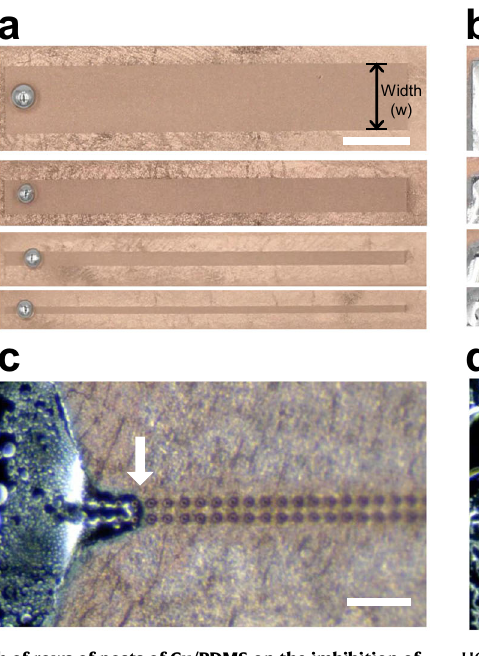
HCl vapor exposure. c , d Wetting of EGaIn on the Cu/PDMS with the ( c ) two rows ( w =75 μ m) and ( d ) one row ( w =25 μ m) of the post patterns. The images were captured10minaftertheHClvaporexposure.Thescalebarsin( a , b )and( c , d )are 5mmand200 μ m,respectively.Thearrowin( c )indicatesthecurvatureofthehead of EGaIn through imbibition.